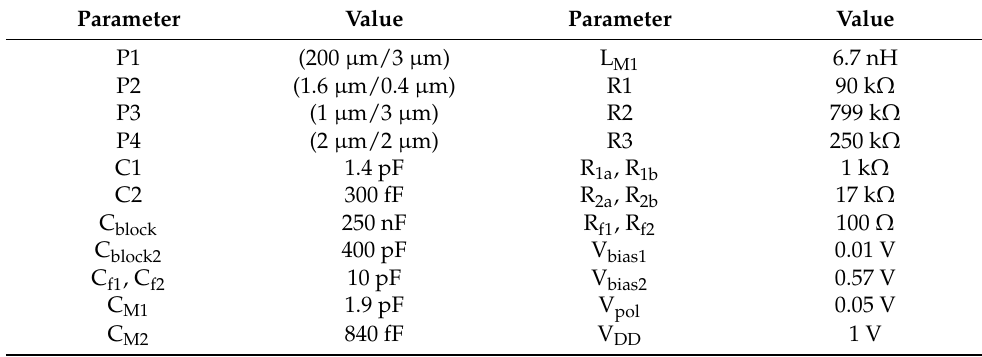
Figure 8. Layout of the two-stage feedback amplifier, total size of 230 × 160 μm 2 .